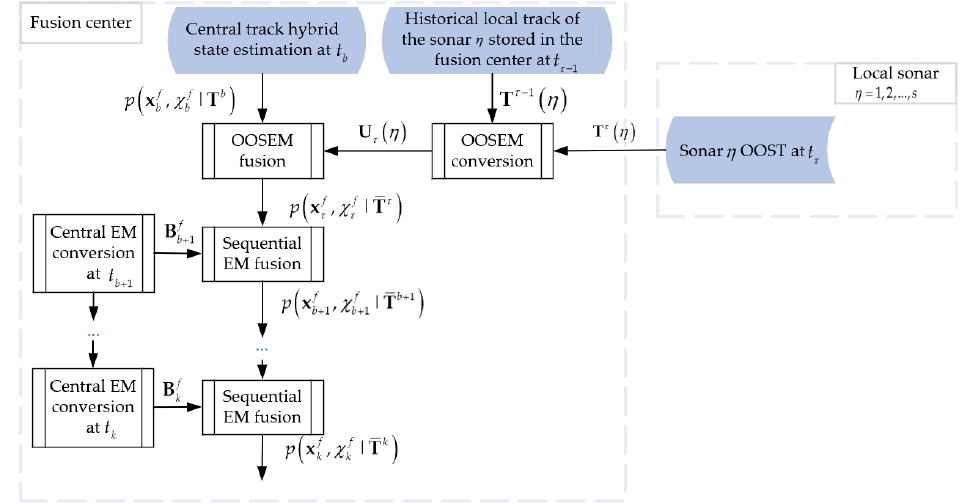
Figure 2. Flowchart of the proposed MFP-IEMF method.